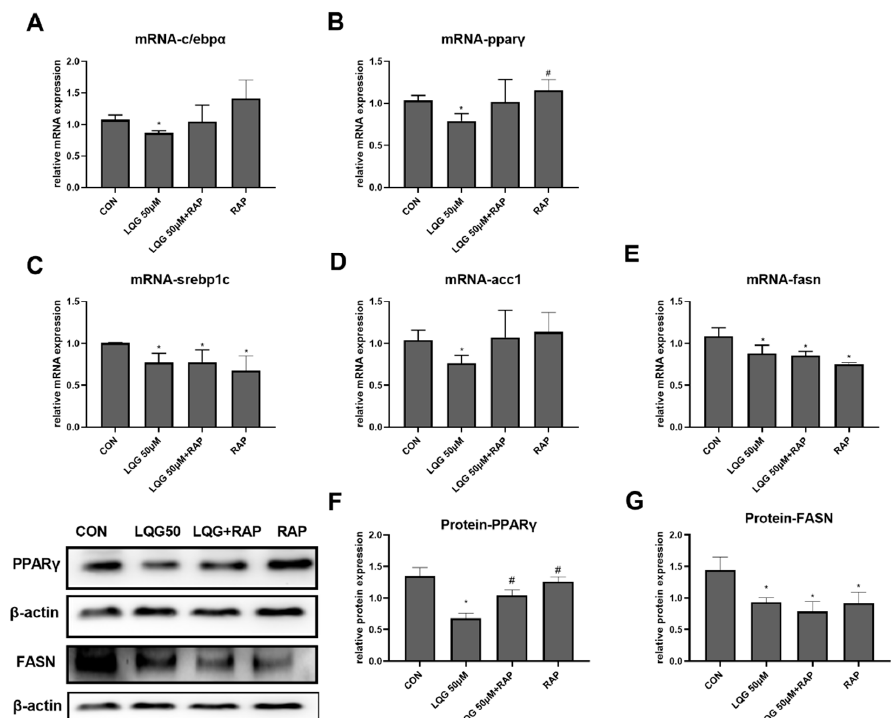
Figure 5. Effects of RAP on modulating lipogenic factors in LQG-treated 3T3-L1 cells. The cells were divided into four groups: control group, 50 µ M LQG group, LQG + RAP group, and RAP-alone group. The mRNA expression levels of ( A ) c/ebp α , ( B ) ppar γ , ( C ) srebp1c, ( D ) acc1, and ( E ) fasn were measured by RT-PCR and the protein levels of ( G ) PPAR γ and ( F ) FASN were analyzed by Western blotting. Protein expression was quantified by densitometry and the relative intensities are expressed in the bar charts. Western blotting bands represent the detection of the proteins from three independent tests. Data are presented as means ± SEMs and analyzed with one-way ANOVA. * vs. control group ( p ≤ 0.05); # vs. 50 μ M LQG-alone treatment group ( p ≤ 0.05).